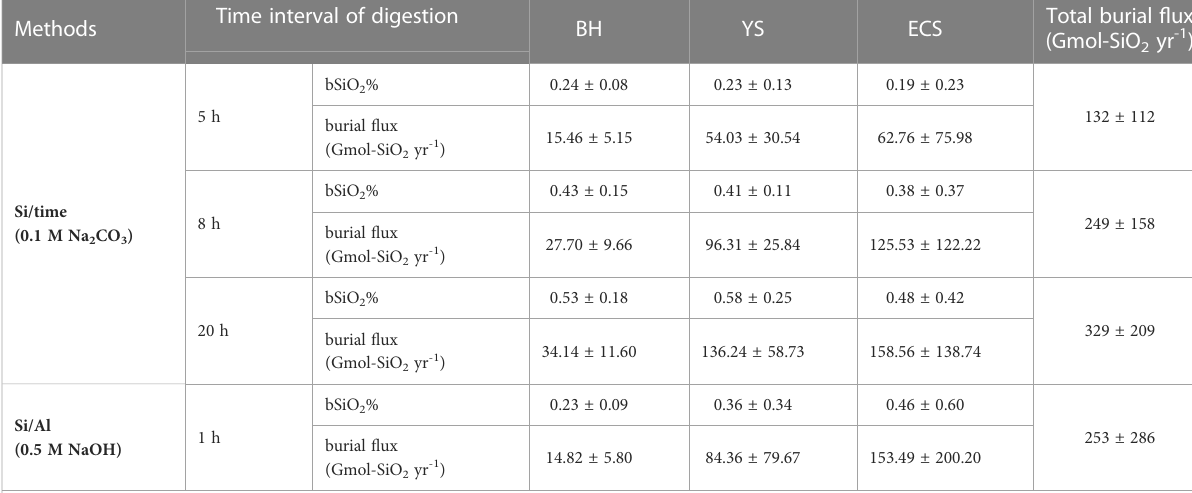
TABLE 6 Burial fl ux of bSiO 2 (Gmol-SiO 2 yr -1 ) of the BH, the YS, and the ECS.